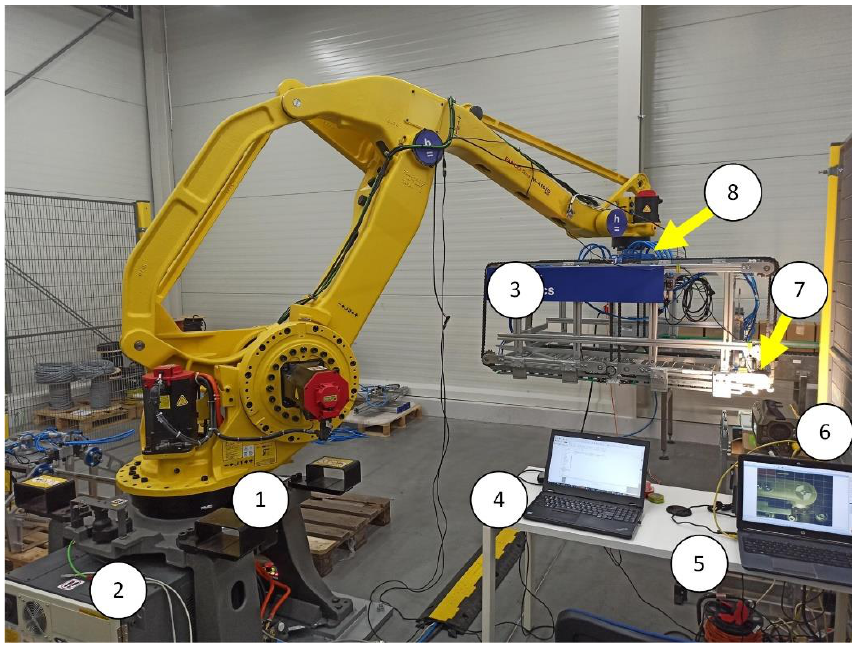
Figure 8. View of the test bench with the FANUC M-410iC/315 robot. 1 — FANUC M-410iC/315, 2 — R-30iB robot controller, 3 — roller shutter gripper, 4 — PC with MT Manager software, 5 — PC with PCC software, 6 — PHANTOM V210 high-speed camera, 7,8 — MTi XSENS.